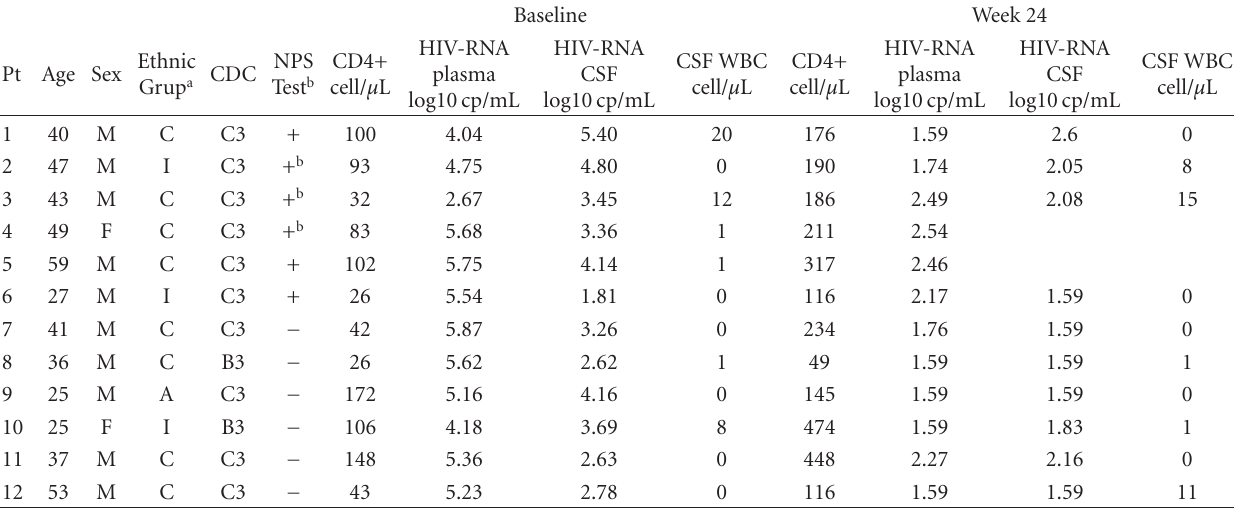
Table 1: Patients’ characteristics.